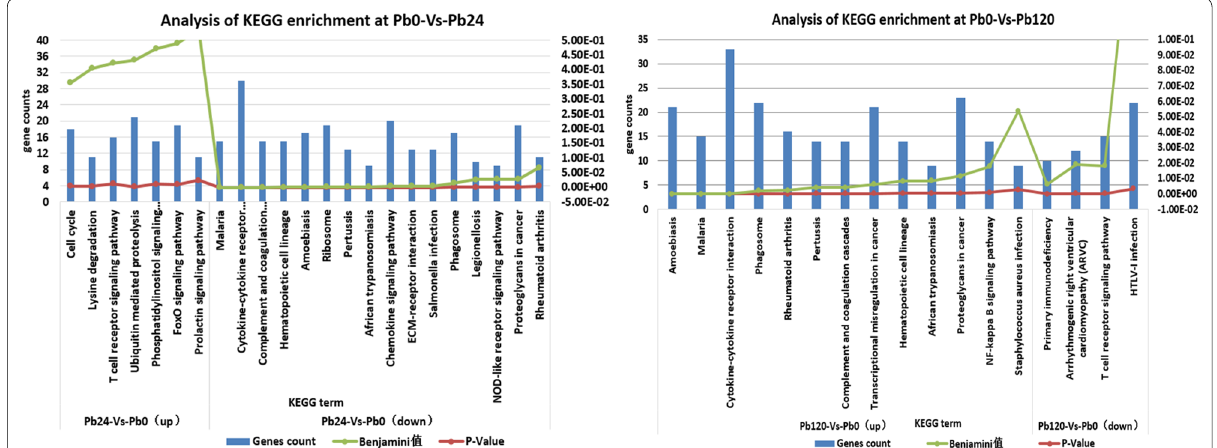
Fig. 4 KEGG analysis. KEGG term is the X-axis and the numbers of enrichment are Y-axis. The Benjamini < 0.05 were defined